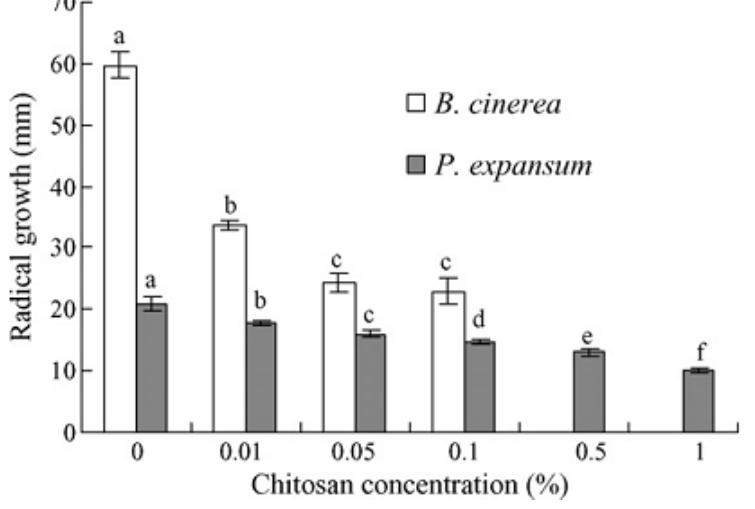
Figure 9. Effects of chitosan concentration on mycelial growth of B. cinerea and P. expansum 3 days after incubation at 25 °C. Bars represent standard deviations of the means. Values followed by different letters are significantly different according to Duncan’s multiple range test at P < 0.05. Reproduced from Reference [59].